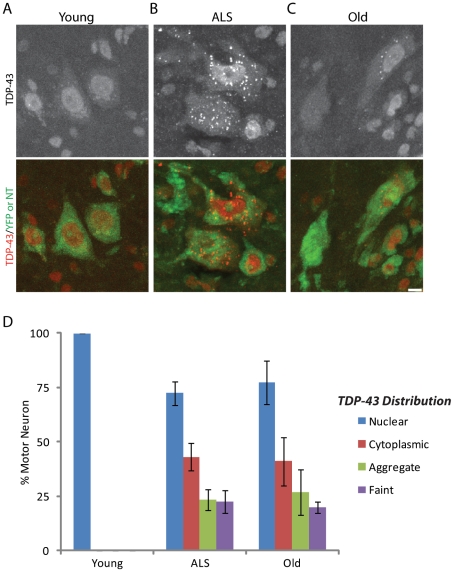
Level and localization of TDP-43 in aging and ALS.A–D) TDP-43 immunoreactivity of motor neurons in caudal spinal cord from young adult wild type (A), old wild-type (B) and symptomatic SOD-G93A (C) mice. Somata are labeled with Neurotrace (A, B) or YFP (C). D) Percent of motor neurons with strong cytoplasmic immunoreactivity, cytoplasmic aggregates, or barely detectable levels of TDP-43 in spinal cord of young adult, old, and symptomatic SOD-G93A mice. Each bar represents mean ± SEM. Scale bar = 20 µm.